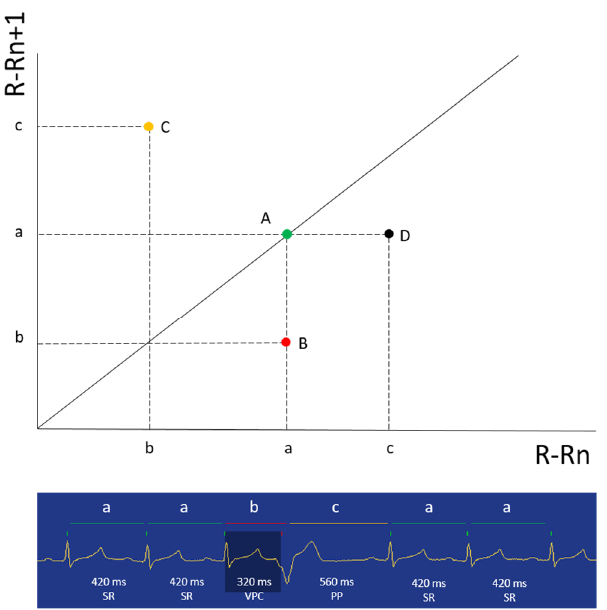
Figure 1. Example figure showing the basic principles of Lorenz plot generation. On the figure bottom, a selected portion of a Holter recording from this study shows a sinus rhythm with regular R-R intervals transiently interrupted by a ventricular premature complex with a post-ectopic pause (PP). Above the tracing, a two-dimensional Cartesian coordinates map of R-R intervals is illustrated. The X-axis is the R-Rn interval and the Y-axis is the R-Rn + 1 interval. In this example, the first two R-R intervals are regular (a), creating a dot on the diagonal line (identity line) (A). The third R-R interval is premature (b); therefore, the correspondent dot moves below the line to point B. The fourth R-R interval is longer due to the PP; thus, the correspondent dot moves above the line to point C. The fifth R-R interval returns to the initial value (a); consequently, the correspondent dot moves to point D. Since the last R-R interval is identical to the preceding one (a), the last dot returns to point A. Repetition of this process using the entire population of R-R intervals recorded during a Holter monitoring creates the final Lorenz plot.